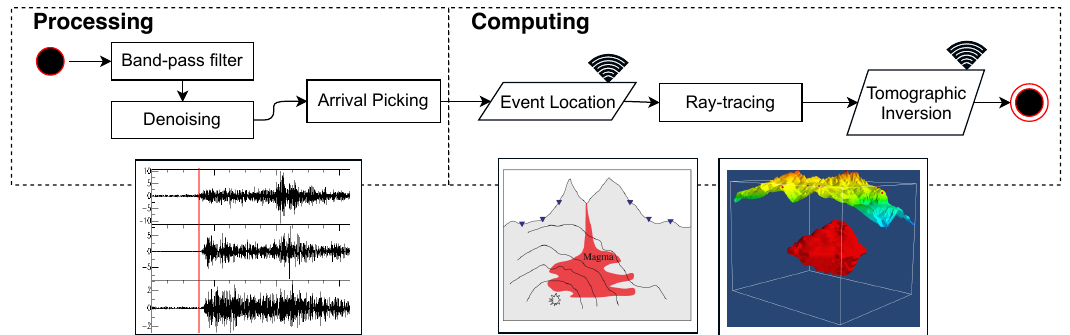
Figure 5. Processing and computing algorithm flows of travel-time seismic tomography. The wireless sign in the figure means communication between nodes is